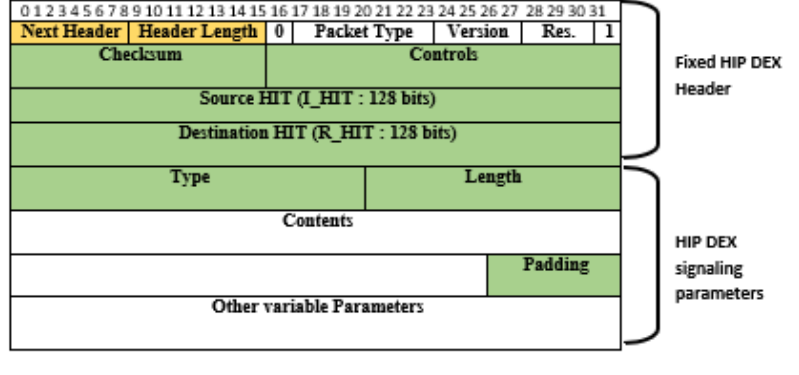
Figure 2. Fixed HIP DEX packets header [9].